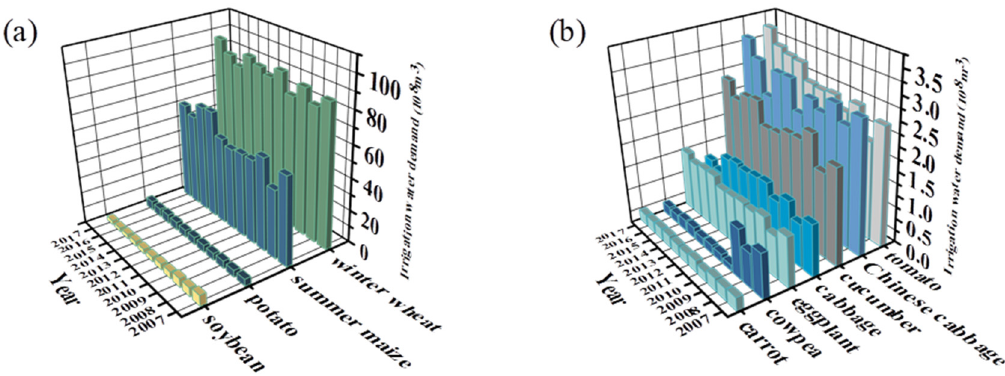
Figure 3. Changes in regional total irrigation water demand of major grain ( a ) and vegetable crops ( b ) in Hebei Province from 2007 to 2017 . ( b ) in Hebei Province from 2007 to